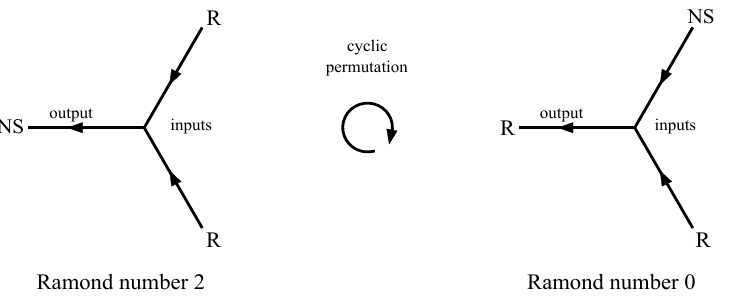
Figure 1 . Cyclic permutation of a vertex changes the de(cid:12)nition of the output and inputs of a product. Since Ramond number is not symmetric between inputs and outputs, products of (cid:12)xed Ramond number are generally not